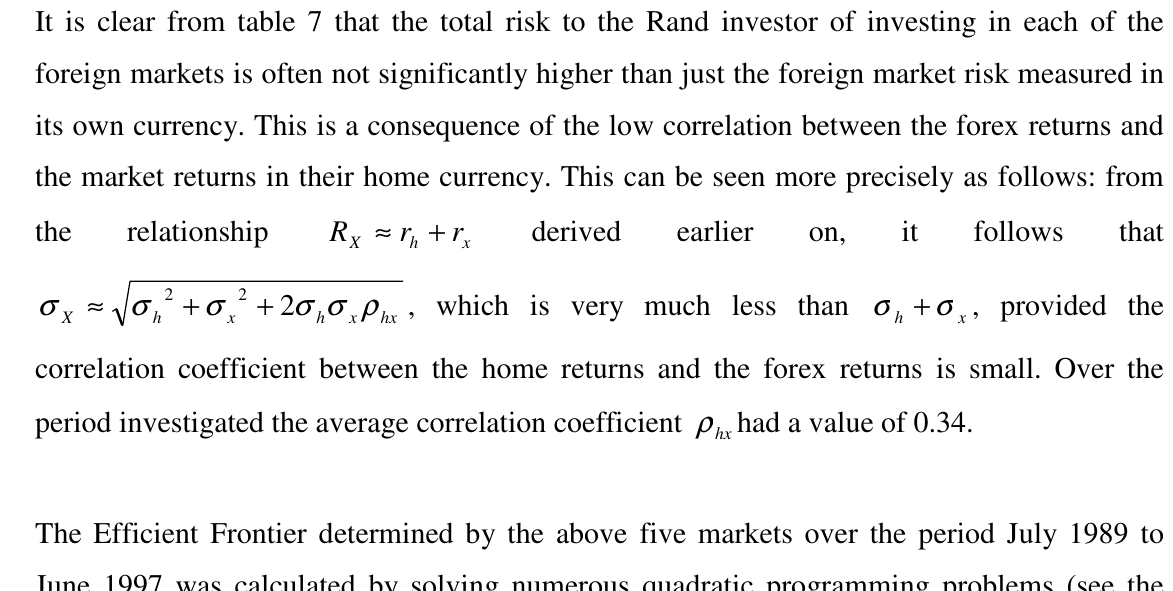
Table 7. South Africa and the big four equity